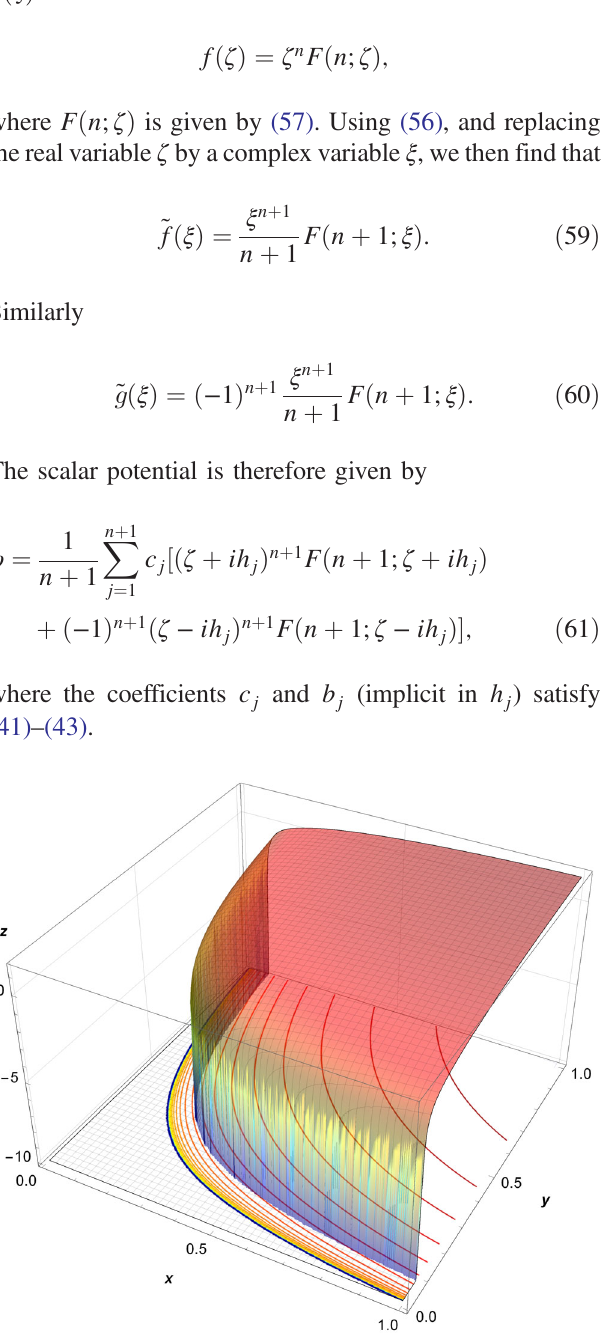
FIG. 6. Surface of constant scalar potential in a representation of the HL-LHC inner triplet quadrupole, with the gradient falling as an Enge function in the fringe field. The overall length scale is arbitrary. The parameters of the Enge function (63) correspond to the first line in Table